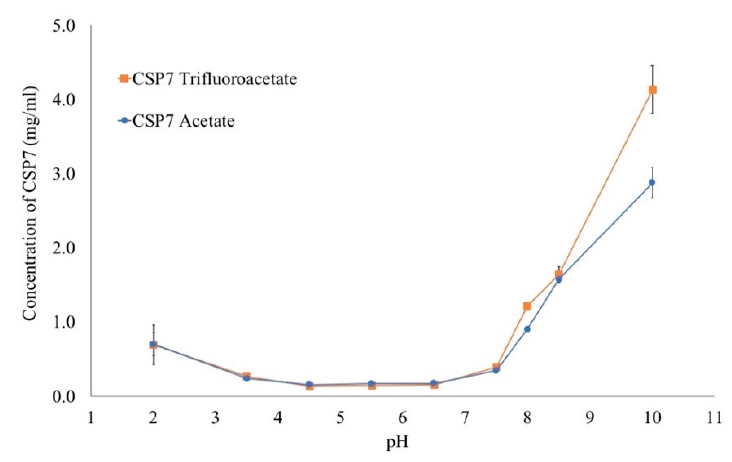
Figure 1. pH solubility profile of CSP7 acetate and CSP7 TFA.